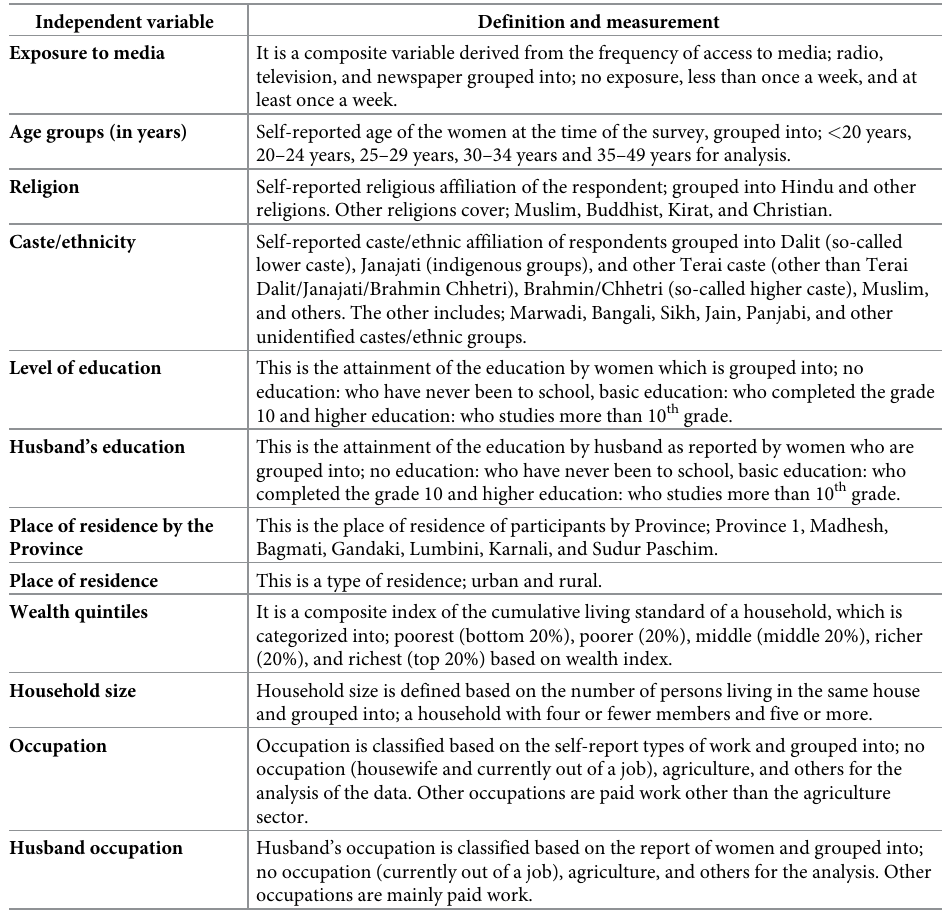
Table 3. Definition and measurement of independent